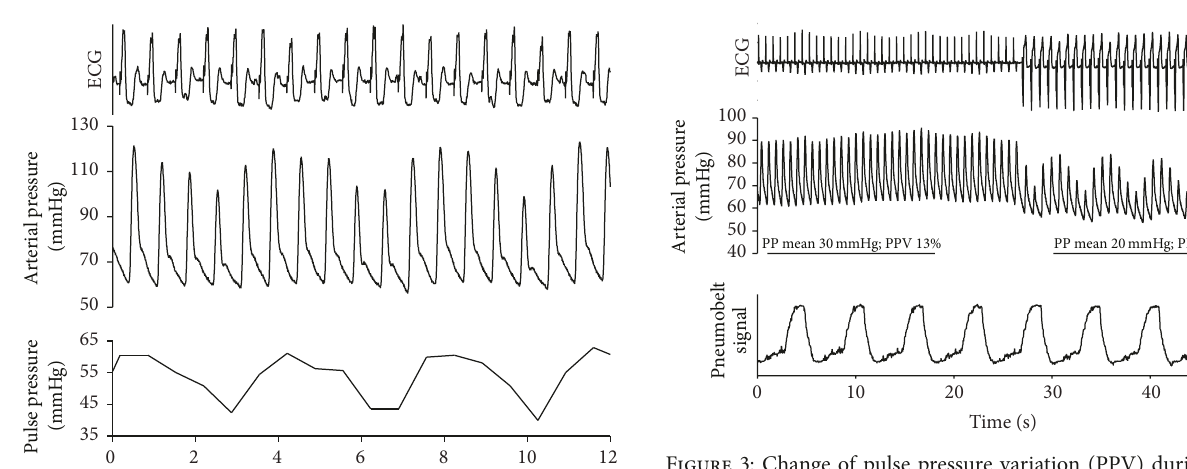
Figure 3: Change of pulse pressure variation (PPV) during sinus and pacemaker rhythm. ECG, arterial pressure, and noncalibrated pneumobelt signals were recorded during the dynamic preload test. While the initial segment of the arterial pressure panel during sinus rhythm indicates minimal changes in pulse pressure (PP) resulting in borderline PPV, the switch to ventricular pacemaker rhythm is accompanied by enormous pressure fluctuations and a severalfold increase in PPV. The straight lines indicate the 3 breathing cycles detected by the pneumobelt during the first and second part of recording. Based on the pneumobelt signal, the arterial pressure swings occurring during the pacemaker rhythm seem to be unrelated to the